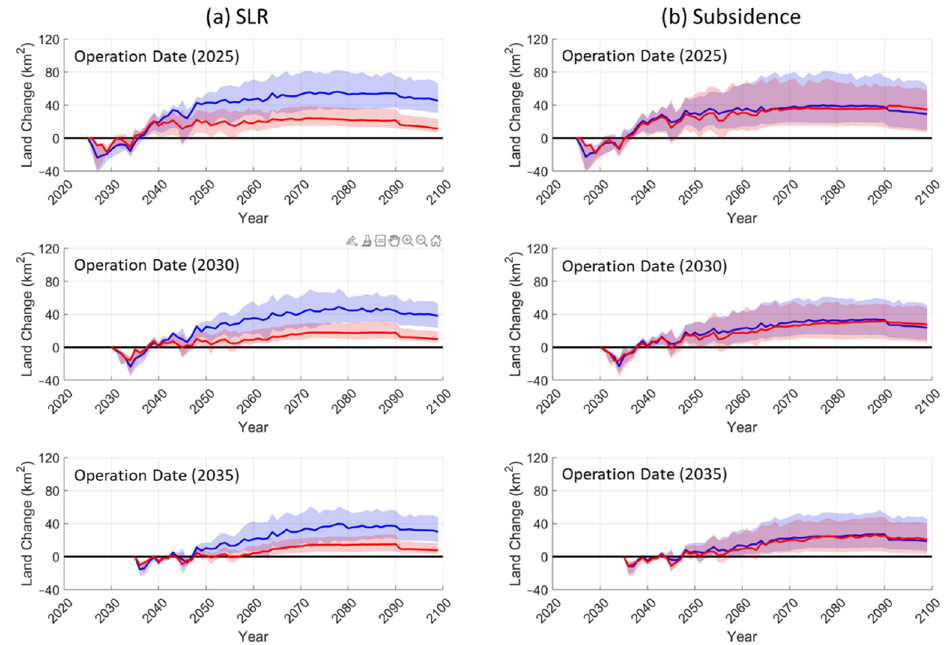
Figure 3. ( a ) Effect of 1-m (red line) and 2-m (blue line) sea level rise (SLR) and ( b ) subsidence (CMP2017—blue line; and BYRNES T19 is red line) on the net land change by 2100. The top row is assuming operation date of 2025, while the middle row is for 2030, and the bottom row is for 2035.